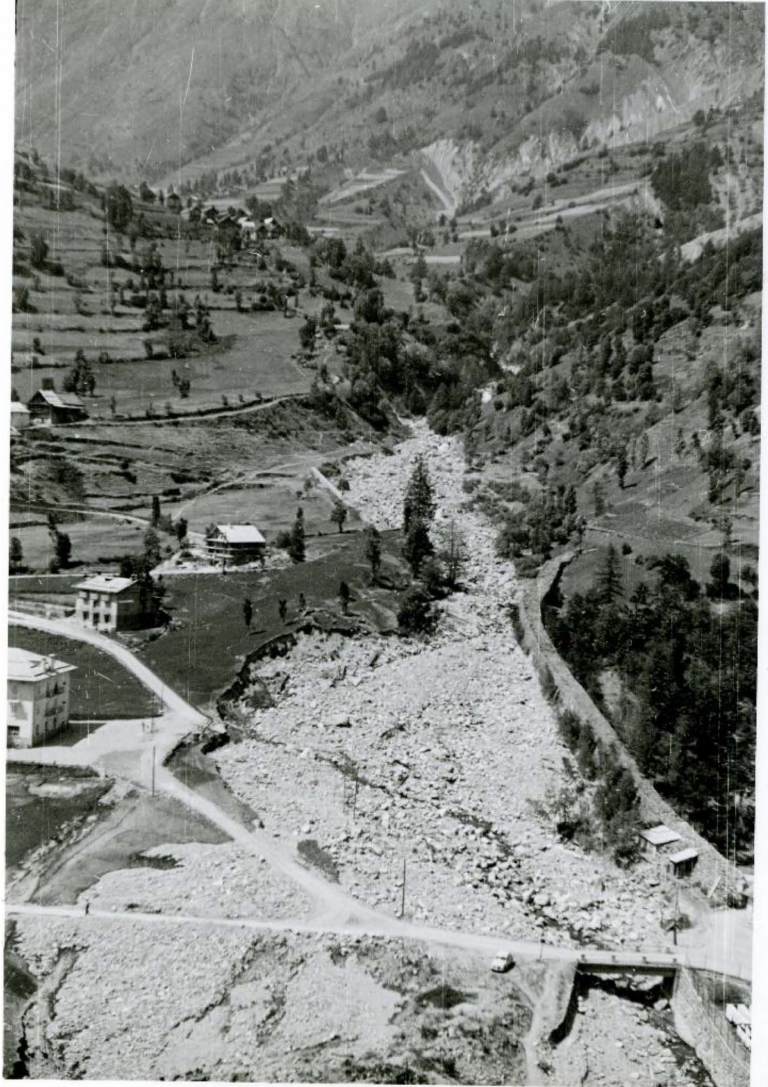
Figure 16. Coarse channel bottom, debris-flow deposits and bank erosion processes that occurred in June 1957 on the alluvial fan of the Ischiator stream near the Bagni di Vinadio built-up area, looking upstream (archives of the IRPI-CNR, Torino,